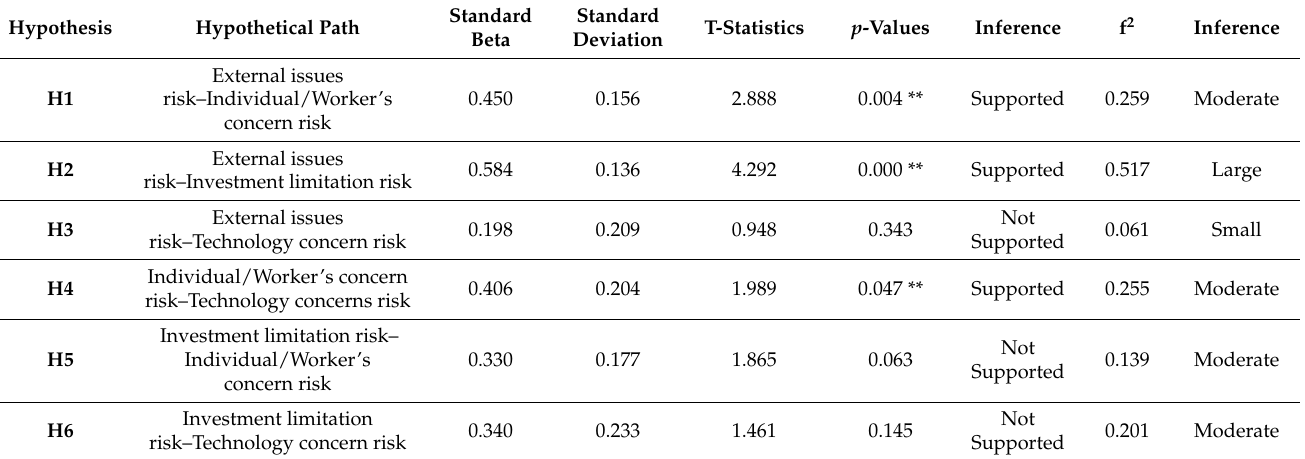
Table 9. Structural model assessment indicating the path coefficients and significance values of the relationships among risk